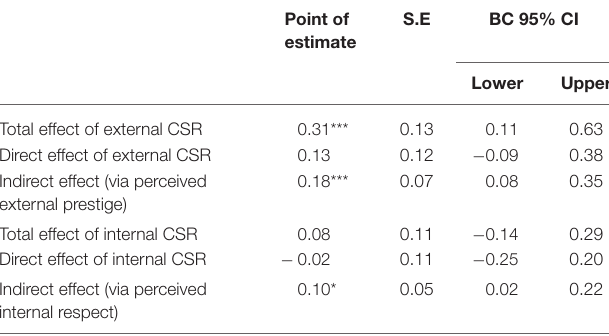
TABLE 3 | Mediation analysis